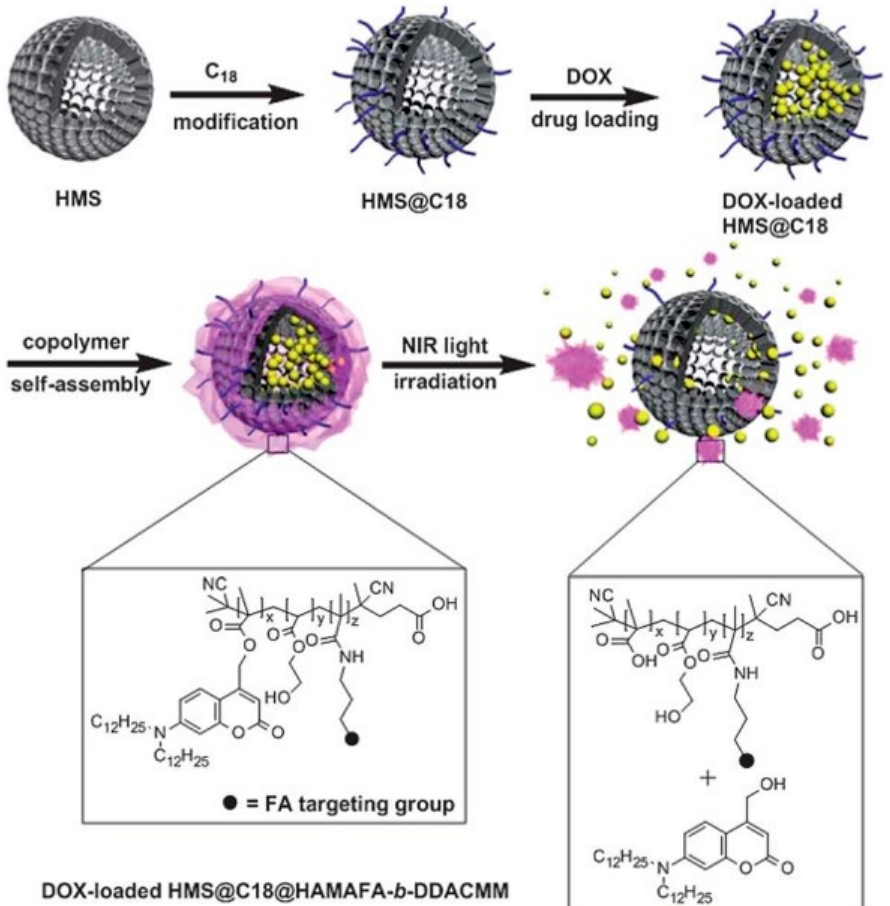
Figure 6. Schematic illustration of the preparation of HMS@C18@HAMAFA- b -DDACMM for drug delivery and controlled release by degradation upon NIR light exposure. The HAMAFA- b -DDACMM is a coumarin and folic acid conjugated copolymer, where the abbreviation HAMAFA denotes hydroxyethylacrylate and N-(3-aminopropyl) methacrylamide-conjugated folic acid segment, and DDACMM denotes 7-(didodecylamino) coumarin-4-yl] methyl methacrylate. Adapted with permission from ref. [55]. Copyright 2013 The Royal Society of Chemistry.